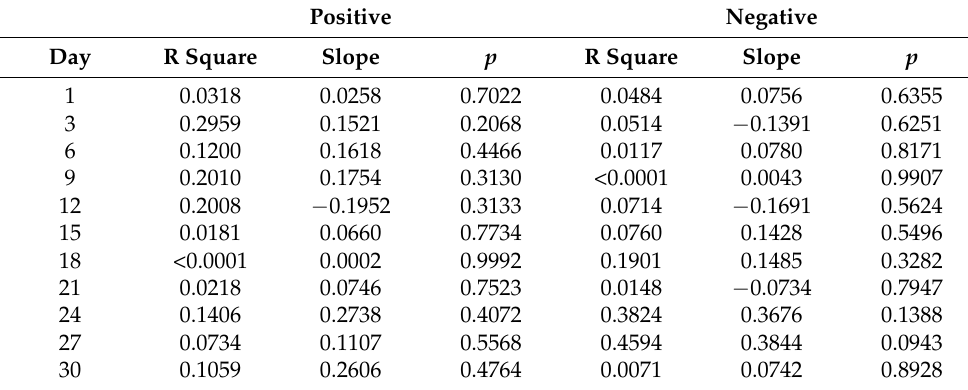
Table 1. Statistical results of SAR curve